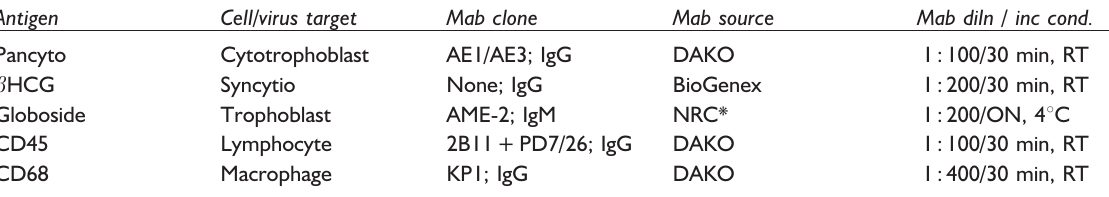
Mab, monoclonal antibody; ICC, immunocytochemistry; diln, dilution; inc cond, incubation conditions; pancyto, pancytokeratins; syncytio, syncytiotrophoblast; none, none available; RT, room temperature; NRC*, Netherlands Red Cross (50); ON,